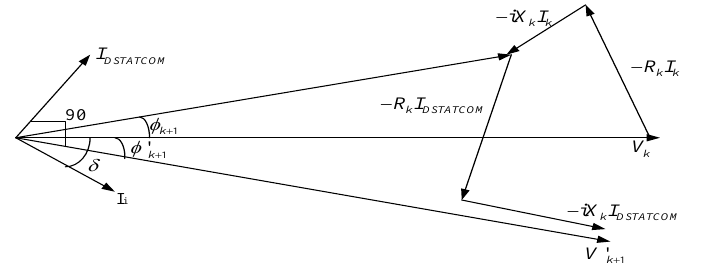
Figure 6. Voltage and current phasor representation of the system with DSTATCOM.